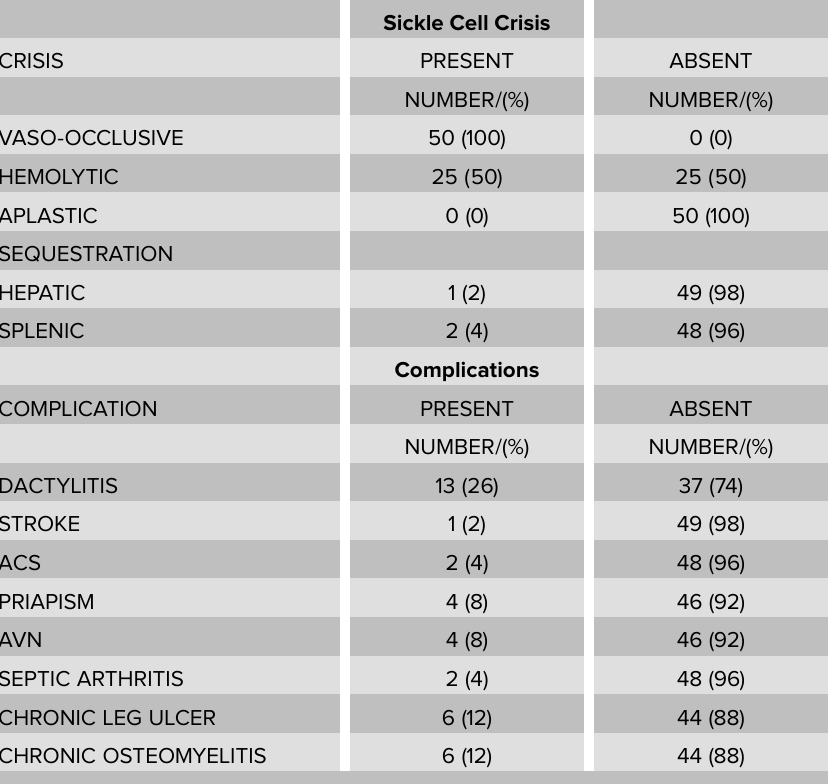
Table 2: History of sickle cell crisis and complications. Sickle Cell